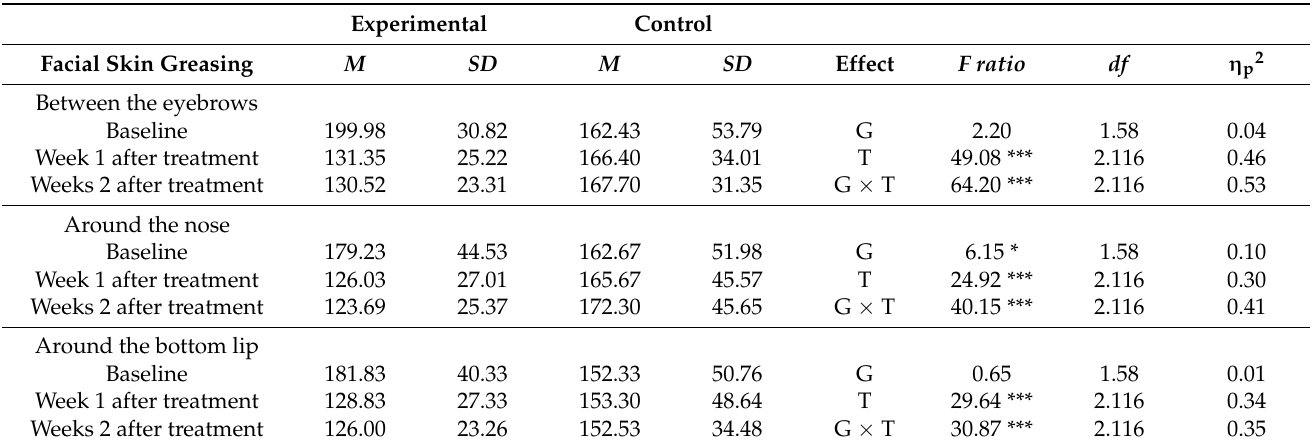
Table 3. Means, standard deviations, and one-way ANOVA with repeated measures for facial skin greasing.